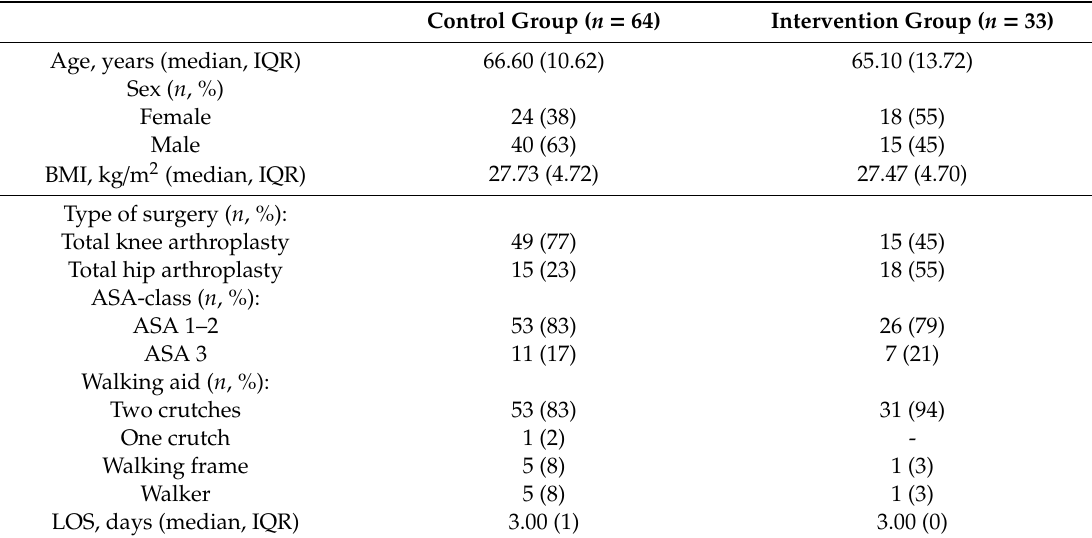
Table 1. Characteristics of study participants.